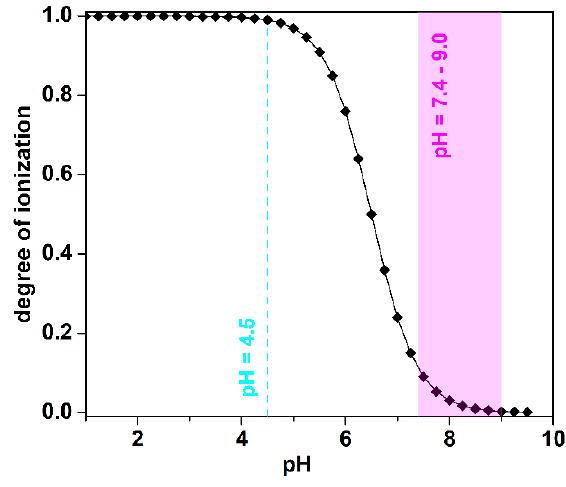
Figure 6. Degree of ionization of chitosan vs. pH.